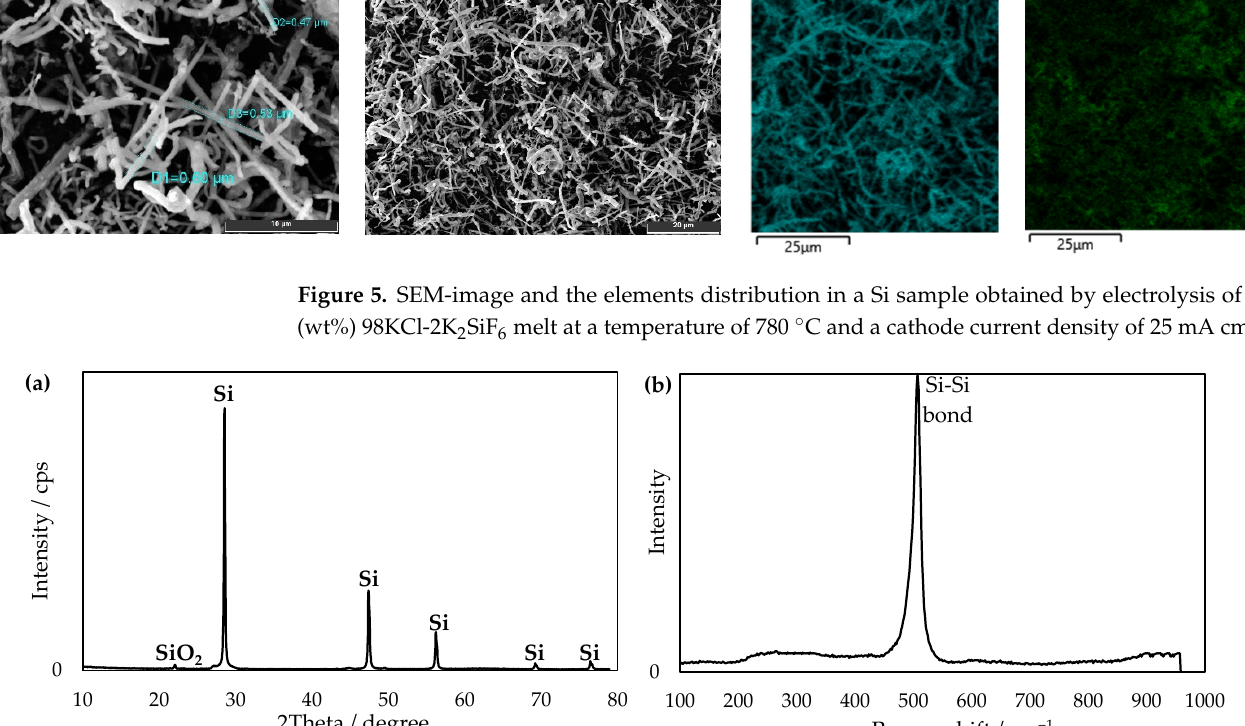
Figure 6. X-ray diffraction pattern ( a ) and the Raman spectra ( b ) of silicon deposit.